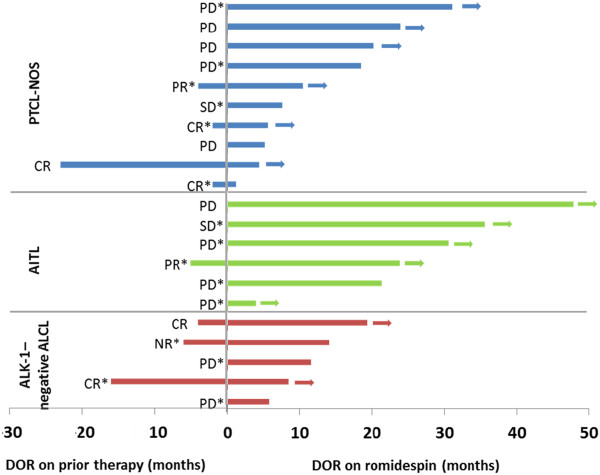
Durations of response for patients who achieved CR/CRu on romidepsin (investigator assessed; n = 21). Only investigators assessed DOR for prior therapy (for patients with PR or CR on prior therapy). Arrows indicate that the patient was censored while in response. * Indicates that the patient received combination chemotherapy as the last prior therapy. NR indicates that the response to prior therapy was not reported.